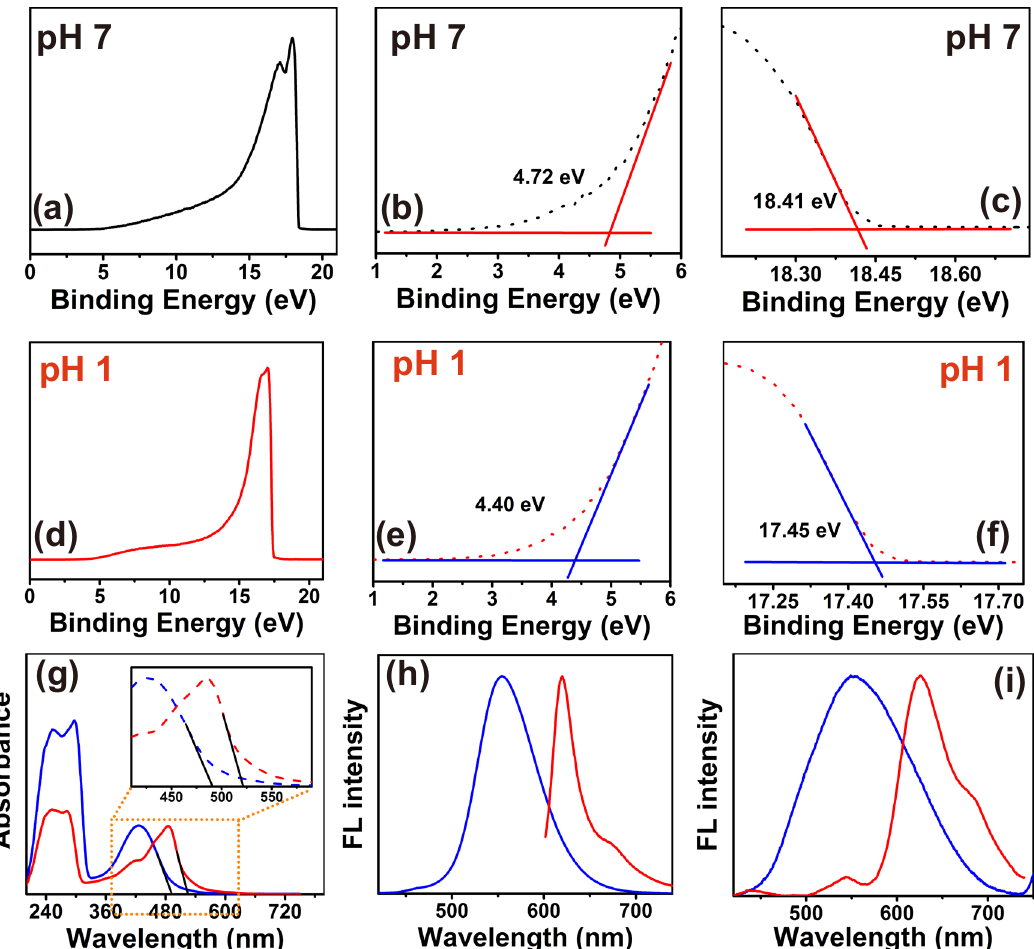
Fig. 7 Energy level structure variation of the CDs by the protonation treatment. a − c full-scale ultraviolet photoelectron spectroscopy (UPS), near Fermi energy (low binding energy) and secondary electron cut-off (high binding energy) regions of CDs before the protonation; d − f UPS, near Fermi energy and secondary electron cut-off regions of CDs after the protonation. g UV − Vis spectra, h one-photon fl uorescence spectra; i two-photon fl uorescence spectra of CDs before and after the protonation. (P-CDs: CDs after the protonation